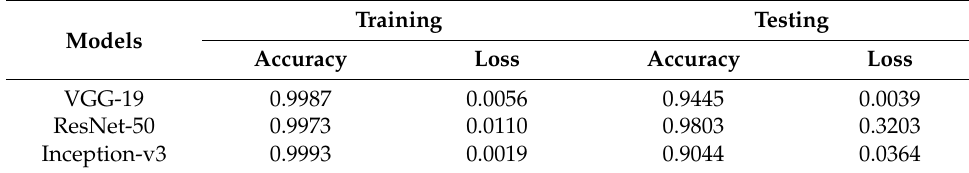
Table 4. Accuracy and loss for VGG-19, ResNet-50, and Inception-v3